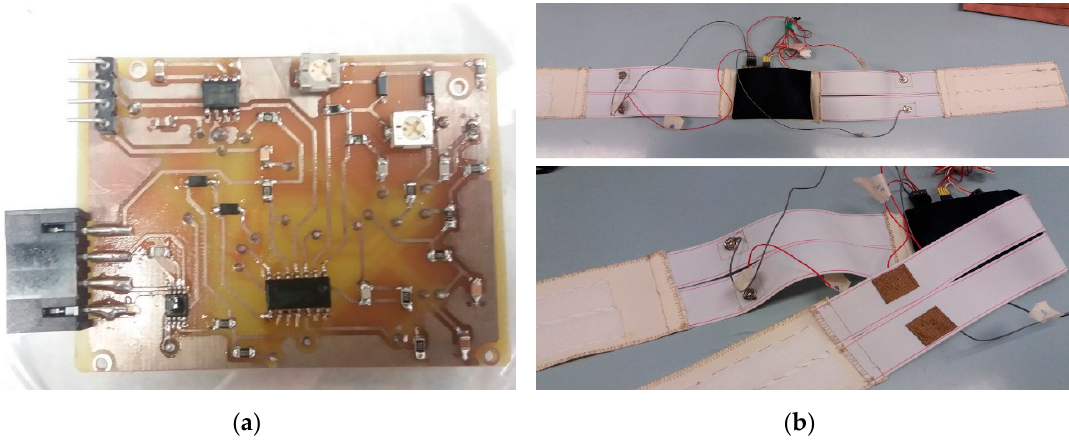
Figure 3. Prototype of the sensorized belt: ( a ) PCB for respiratory and cardiac signal acquisition; ( b ) Stretchable belt with textile electrodes and pocket for battery pack, PCB and micro-controller placement.